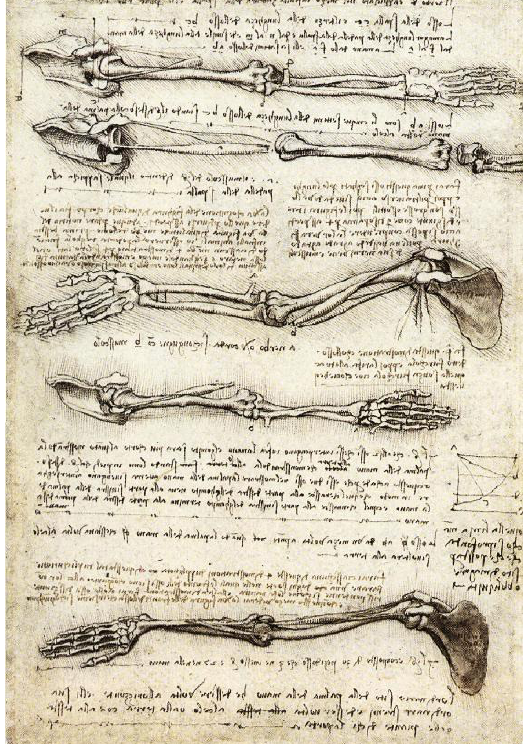
Figure 1. Studies of the Arm showing the Movements made by Biceps, c. 1510, a drawing by Leonardo da